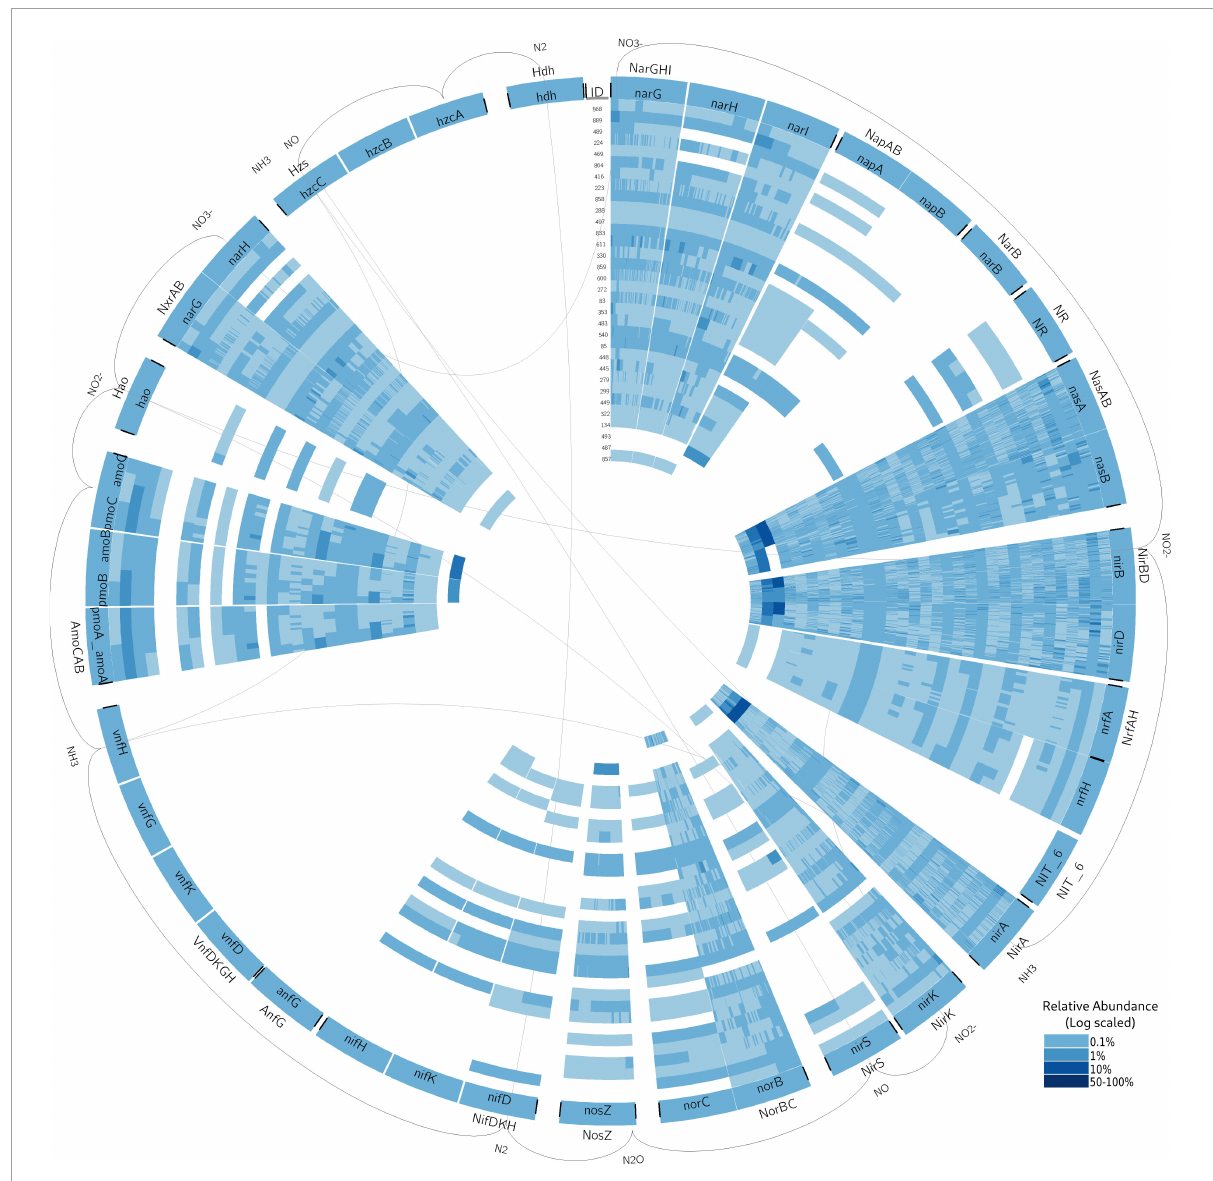
FIGURE2 Circular visualization of all nitrogen-cycling genes richness and relative abundance. Read the figure clockwise, from the exterior of the circle to the interior. The nitrogen-cycle reactions (based on Table 1 ) are illustrated by the chemicals linked with black external links. Within each link, all proteins that can perform those reactions are included. The proteins are within bold black ticks and divided into blocks, each block relative to the gene encoding a subunit of the protein. For example, NarGHI protein is divided in three blocks, for the genes narG , narH, and narI . Internal light gray links connect the molecules that are repeated. The 32 metagenomes are plotted as heatmaps, with respective unique codes. Each heatmap was divided by the number of different sequences where the gene (of the specified block) was found. The color is proportional to the relative abundance (scale log 0 . 05